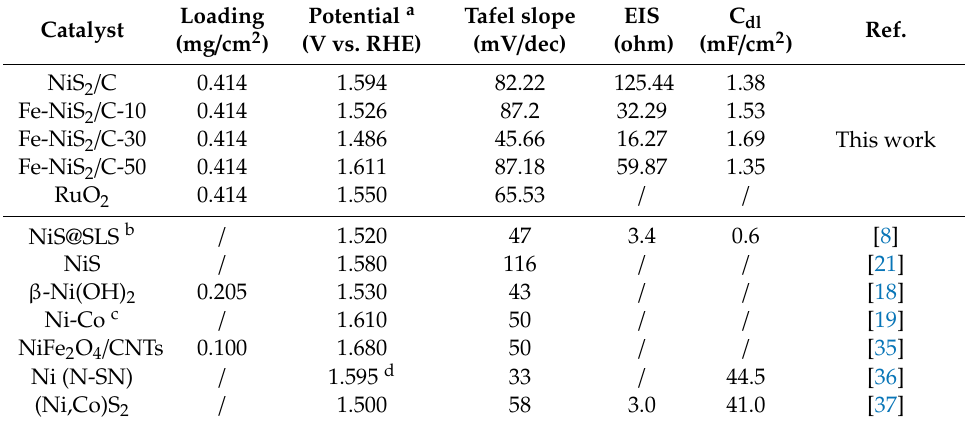
Table 2. Summary of the key OER catalytic parameters of the series samples in this work and some recently reported Ni-based OER electrocatalysts in 1.0 M KOH.